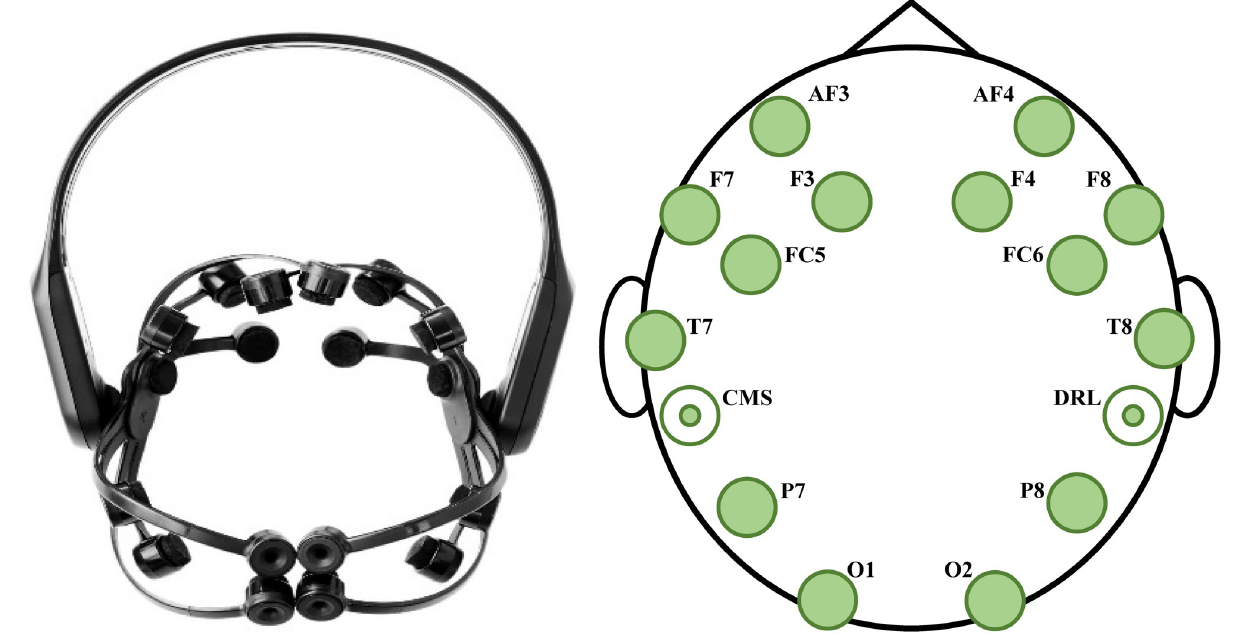
Fig 10. The Emotiv EPOC X and its electrode